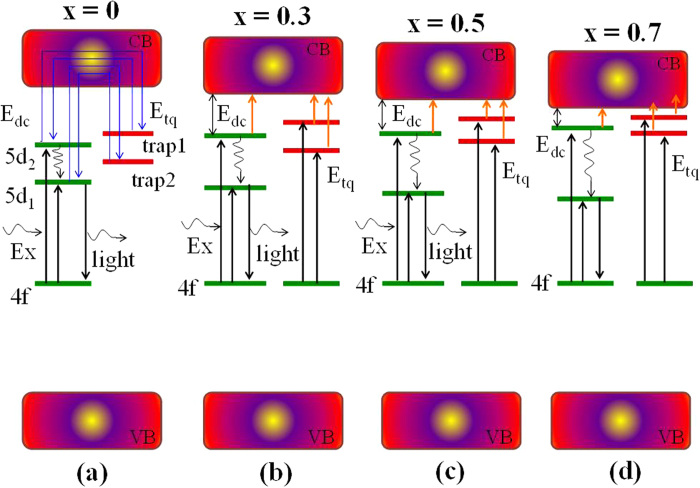
The relative position of 5d1 and 5d2 of Ce3+ and the relative depth of trap 1 and trap 2 in the band structure of (Y1−xGdx)3Al5O12: Ce3+.